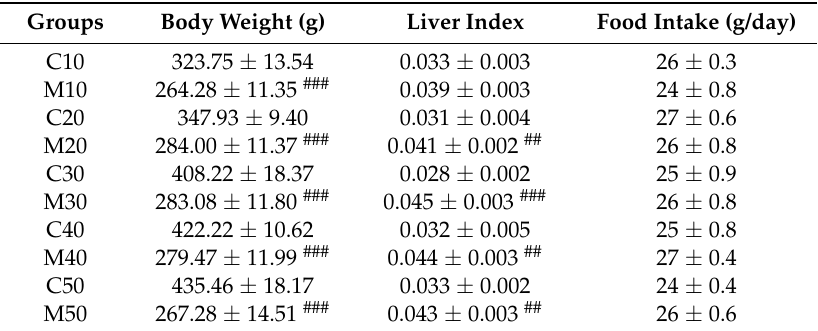
Table 1. Effect of high fat-sucrose diet on body weight, liver index and food intake of Sprague-Dawley (SD) rats (Mean ± Standard Error of Mean (SEM), n = 6). Liver index: the ratio of liver wet weight and body weight. Compared with the corresponding control group, ## p < 0.01, ### p < 0.001.